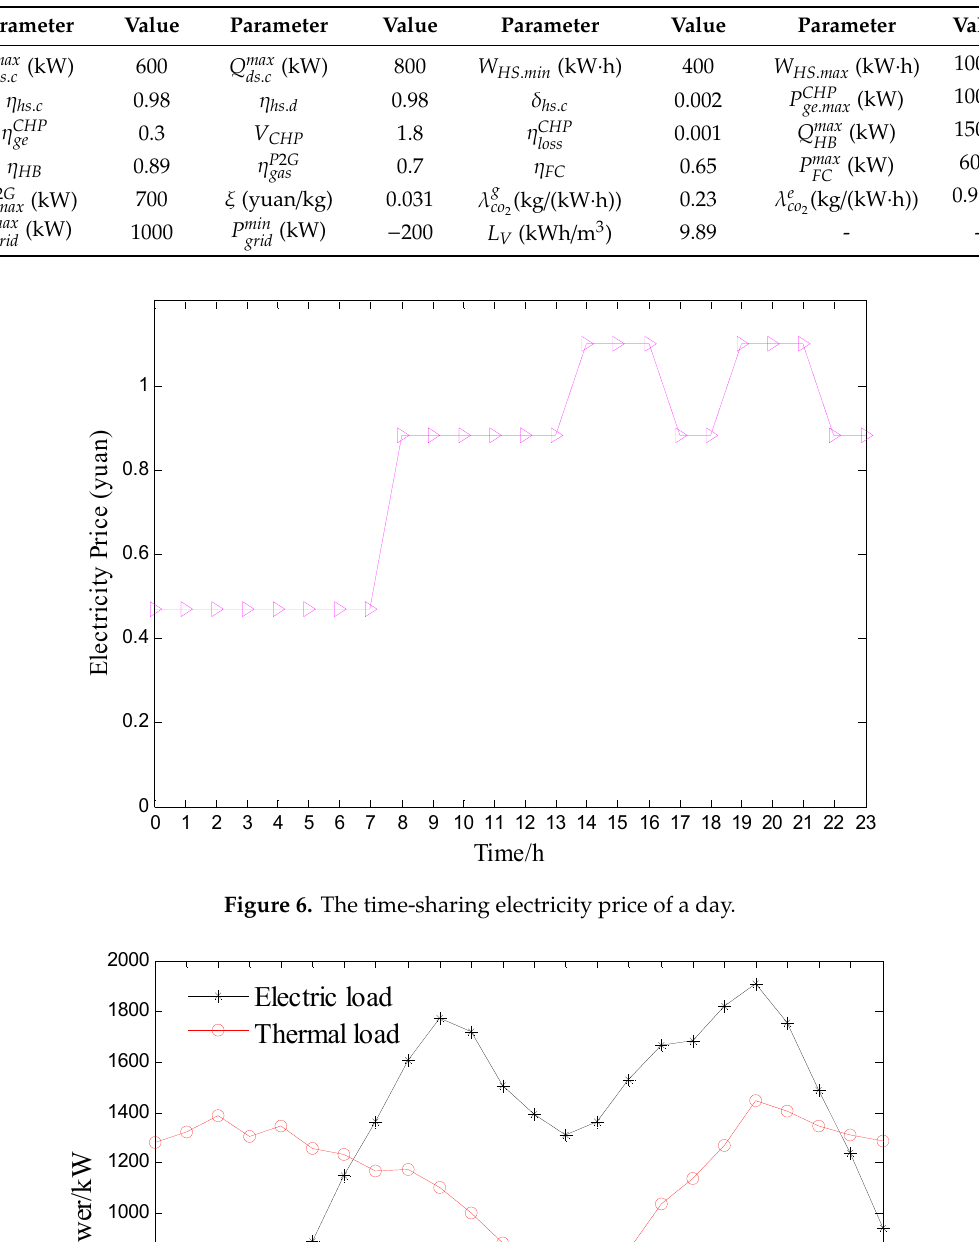
Table 1. Simulation Parameters.